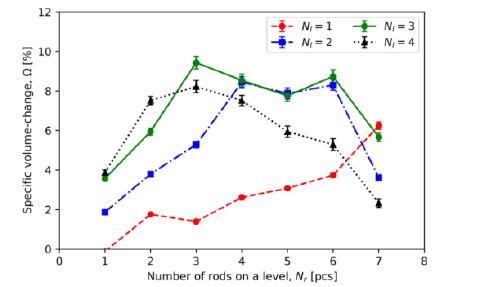
Fig. 4. Specific-volume change versus number of rods on each level, for different